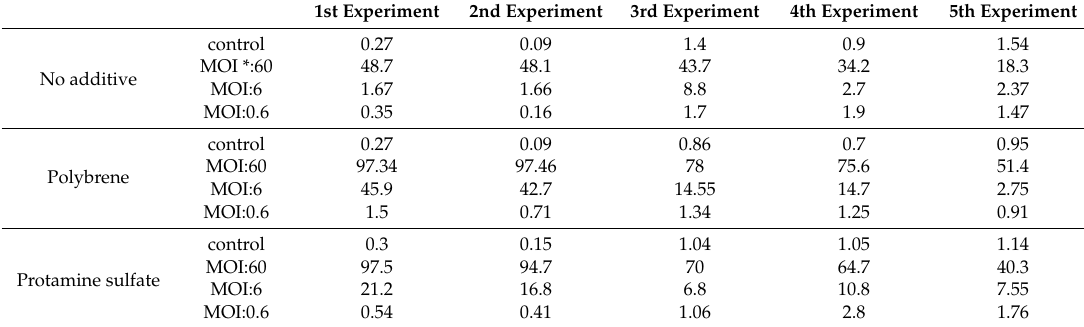
Figure 6. Comparative analysis of GFP expression in ovine macrophages, by flow cytometry, at various multiplicities of infection on Day 8 post transduction. Each MOI condition was repeated two times. Mock-transduced cells served as a negative control. GFP: green fluorescence protein; MOI: multiplicity of infection. Table 2. Detailed results from all the experiments performed to determine the transduction efficiency. Numbers indicate the percentage of GFP-positive cells 3 days after transduction.